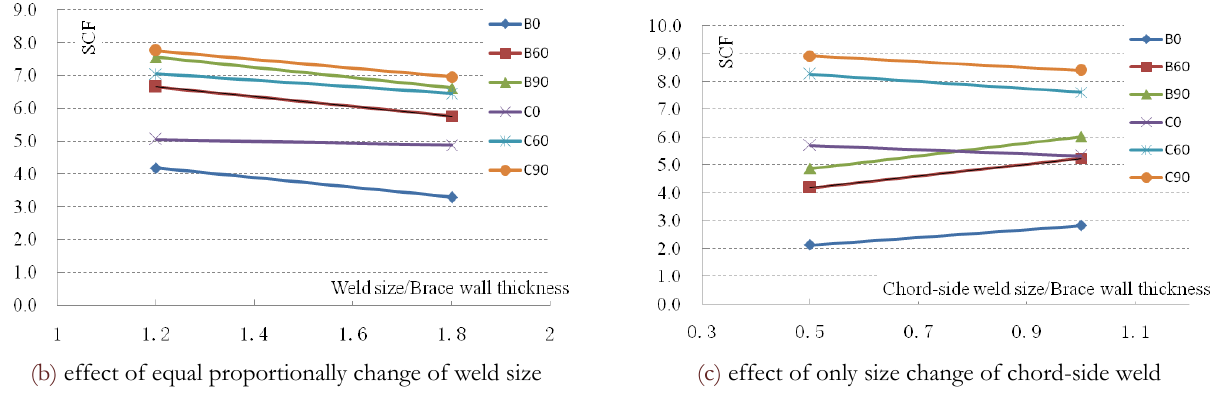
Figure. 9: Effects of weld size on the